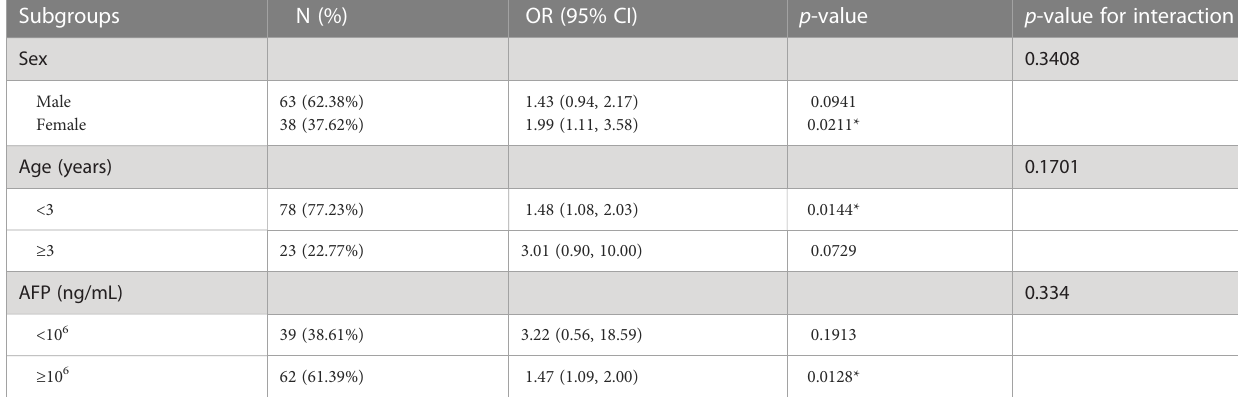
TABLE 2 The association between pretreatment SUA and PRETEXT staging IV strati fi ed by baseline characteristics. Subgroups